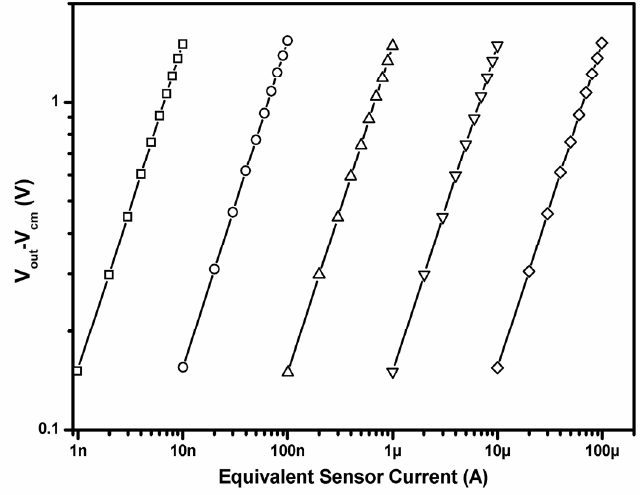
Figure 13. Equivalent sensor current versus V R 2 value of each current range is greater than 0.99998.